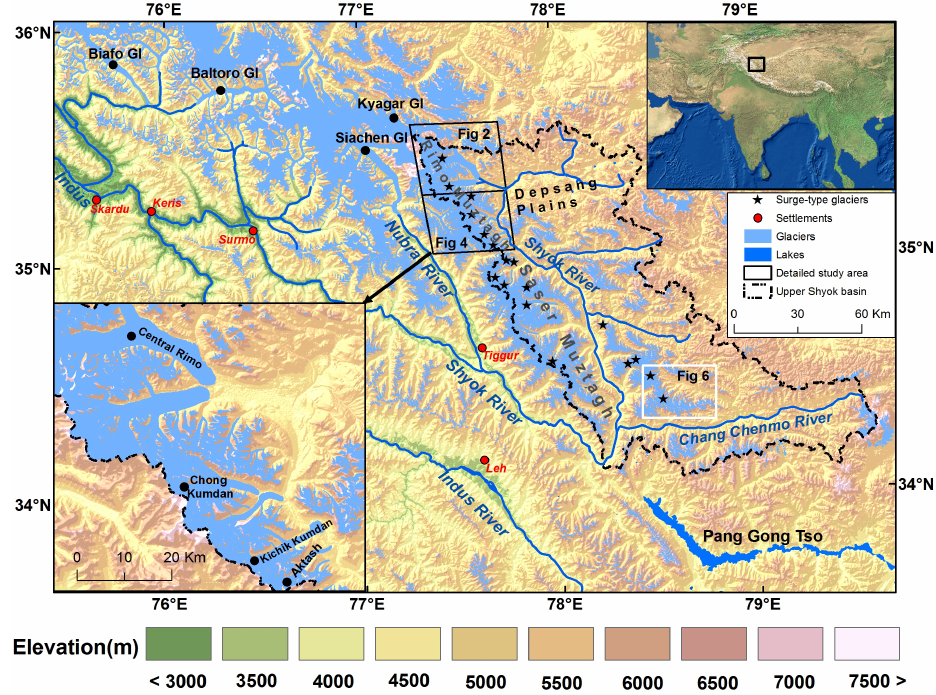
Fig. 1. Location of upper Shyok valley, northeast Karakoram with four glaciers studied in detail. Glacier outlines are based on 2002 August Landsat ETM + imagery. The colour-coded elevation is based on SRTM3